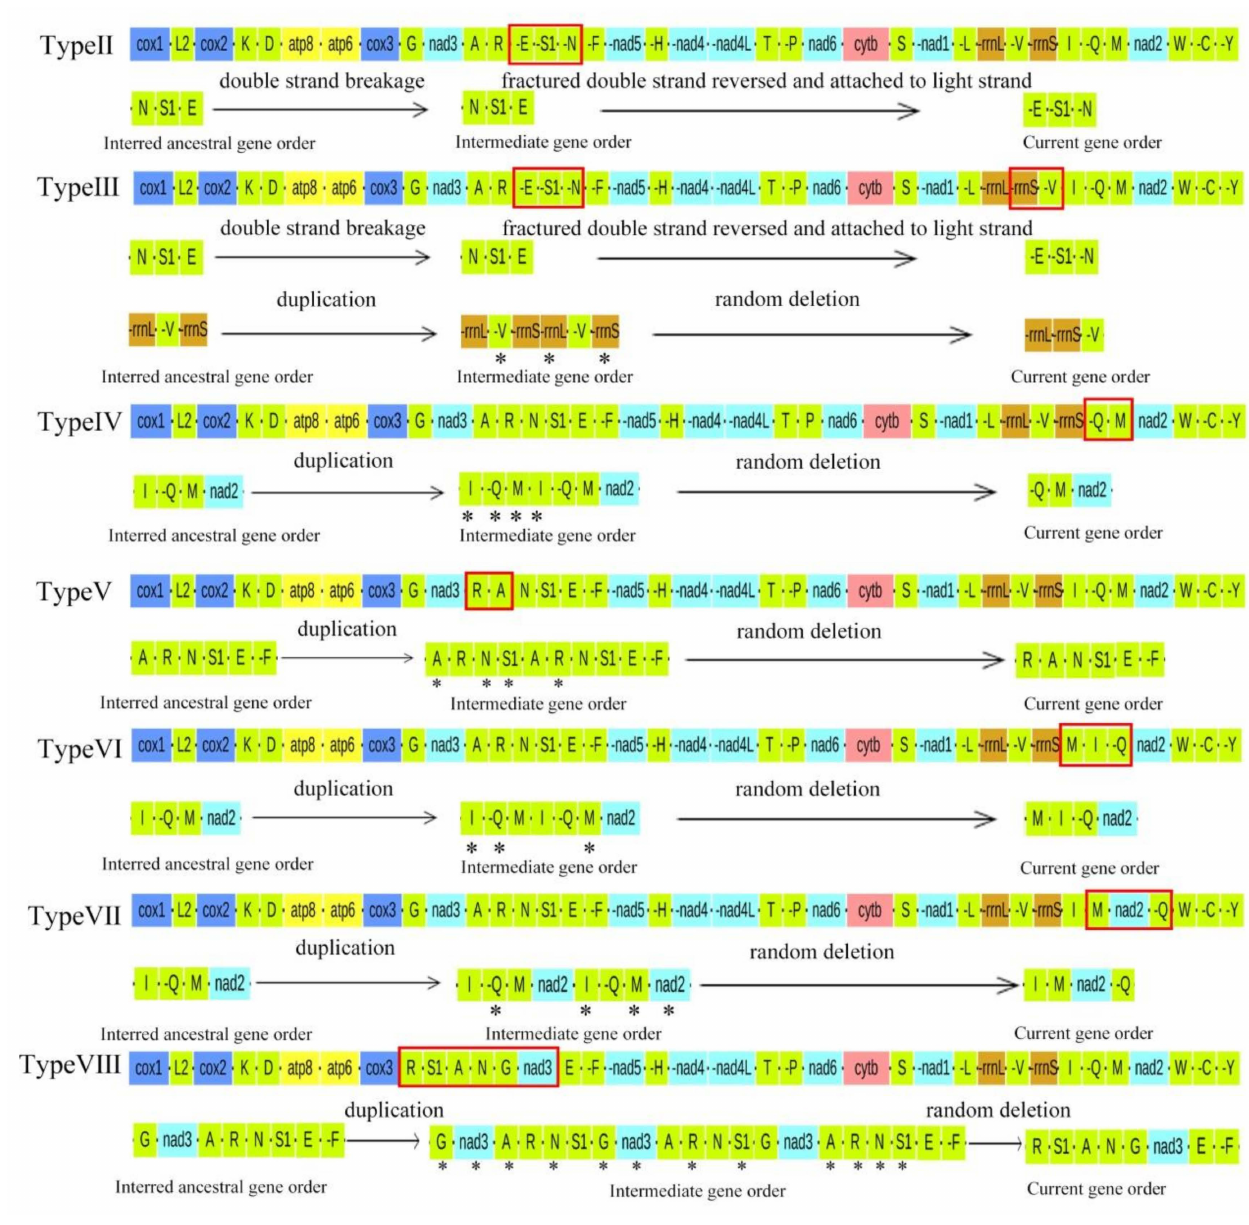
Figure 5. The mechanisms for the eight gene arrangement types in the Ensiferan mitogenome. Genes encoded by the heavy strand (J-strand) have been denoted using a minus sign, whereas those encoded on the light strand (N-strand) have been denoted without one. Genes marked with an asterisk represent ones that were randomly deleted. Differently colored boxes represent different